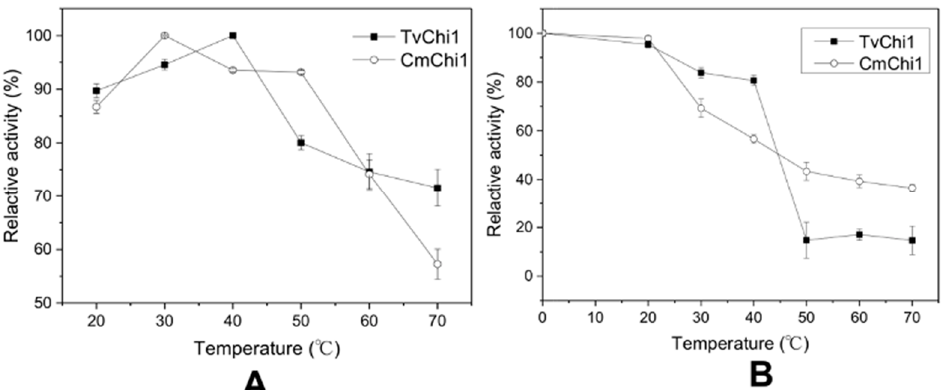
Figure 2. Effect of temperature on activities of the TvChi1 and CmChi1. ( A ) The optimal temperature for TvChi1 and CmChi1; ( B ) the temperature stability for TvChi1 and CmChi1. Data are given as means ± standard deviation, n = 3.